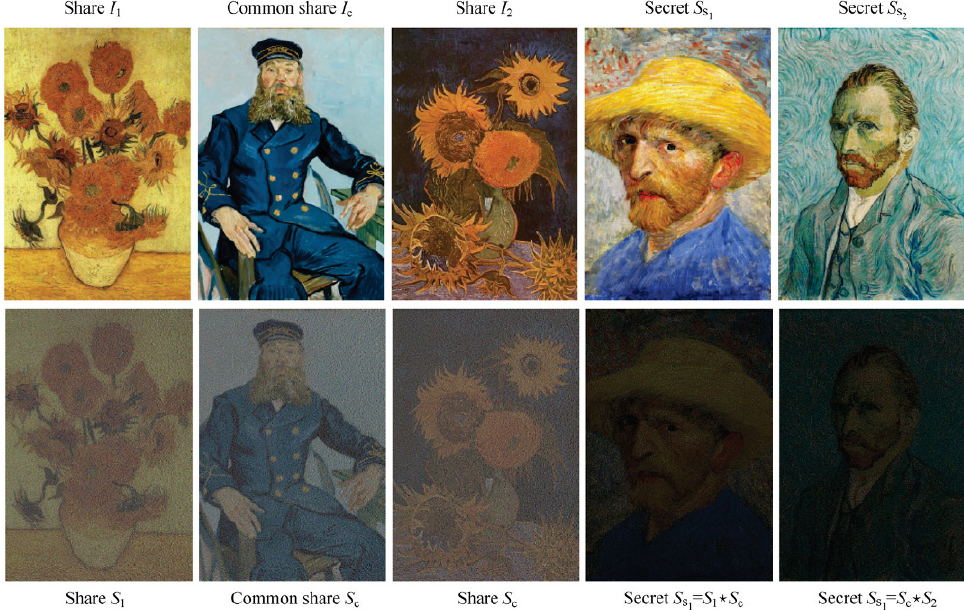
Fig. 5 Top: input images; original images are 463 × 680 pixels. Bottom: proposed color EVCS results; the two portraits on the right are the computed superimposition results of a common share and the corresponding share.